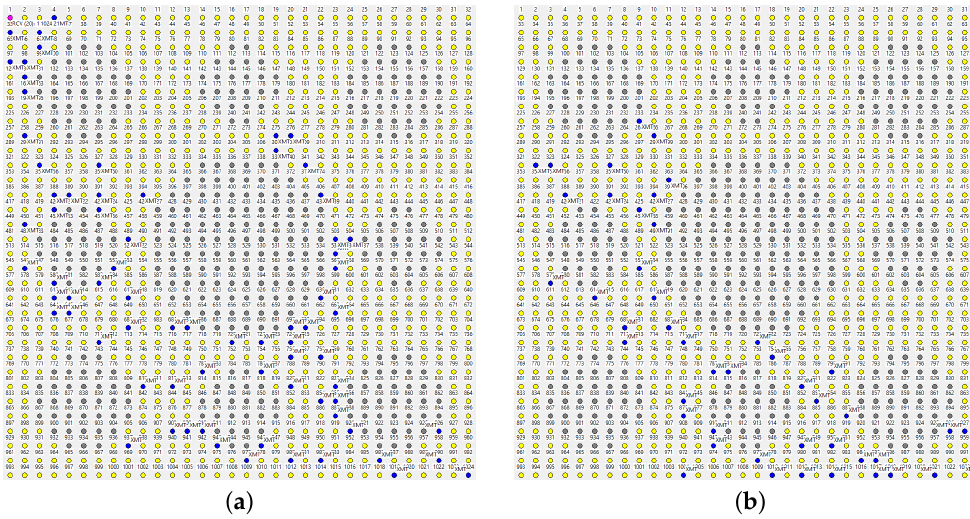
Figure 9. Forwarding around holes (massive attack). ( a ) Successful path; ( b ) failed path.